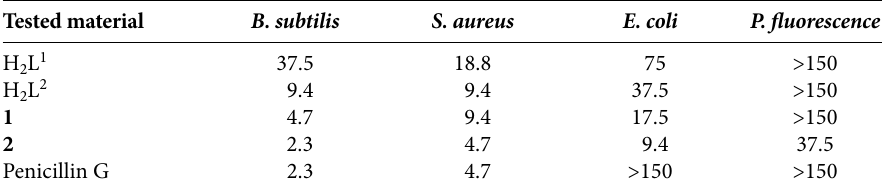
Table 4. Antimicrobial activities of the compounds with minimum inhibitory concentrations (μg mL –1 ) Tested material